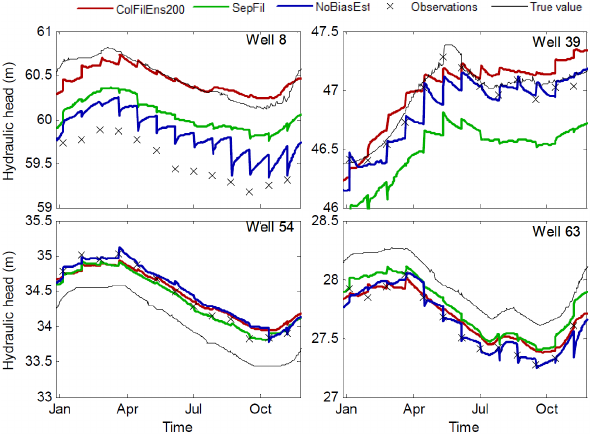
Figure 4. Groundwater head as a function of time in four selected observation locations for the year 1972 (synthetic